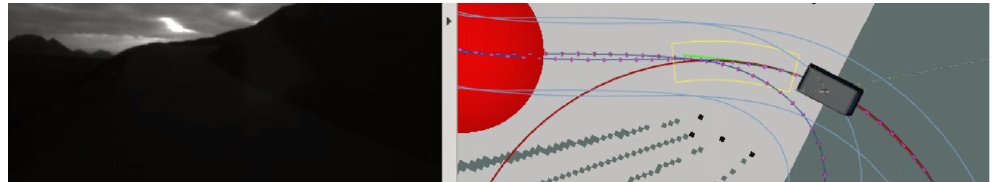
Figure 8. Wrong aperture ring of frontal camera. Bad lightning.